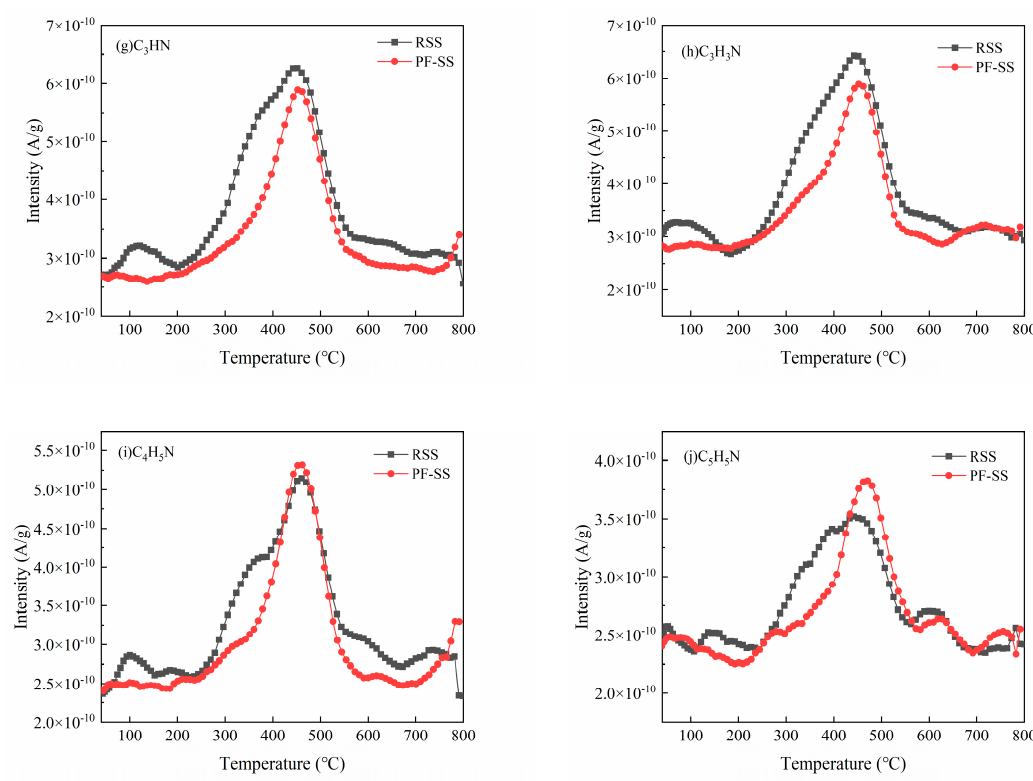
Figure 3. Main N-containing pollutant gas products released during the pyrolysis of different sludge samples. ( a ) NH 3 ( b ) HCN ( c ) C 2 H 3 N ( d ) HNCO ( e ) C 2 H 7 N ( f ) NO 2 ( g ) C 3 HN ( h ) C 3 H 3 N ( i ) C 4 H 5 N ( j ) C 5 H 5 N. Table 3. Peak integrated areas of gas products containing N pollutants.